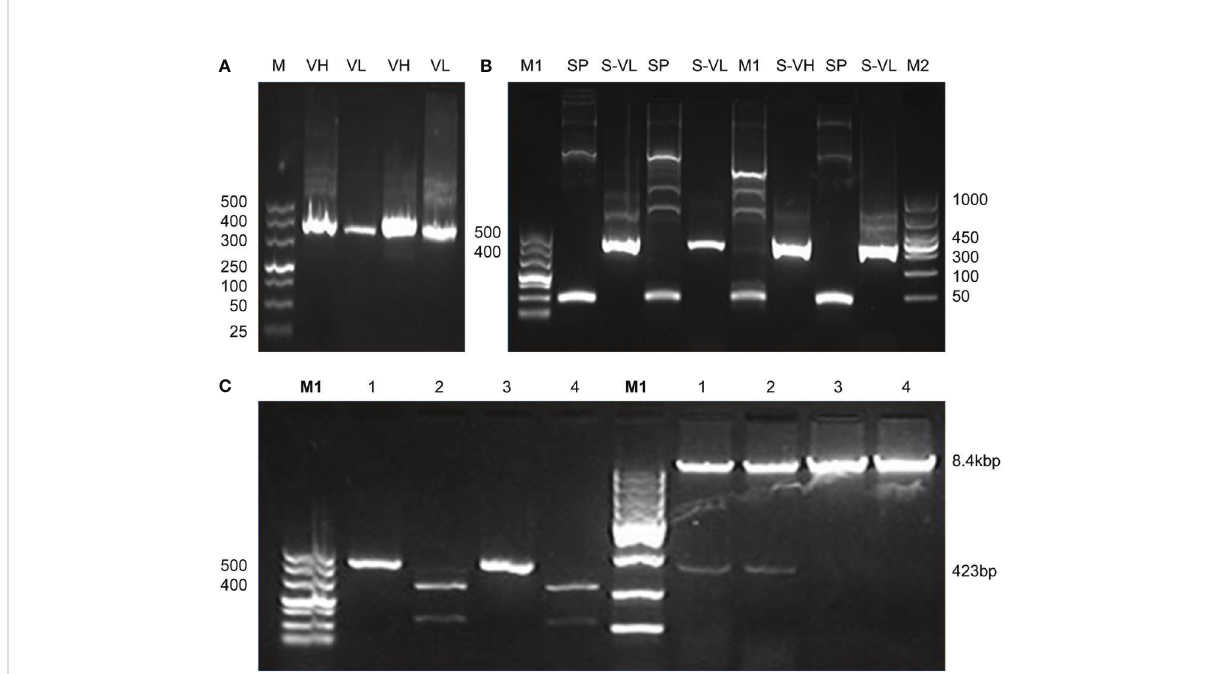
FIGURE 2 (A) Polymerization and ligation of signal peptides with VH/VL fragments. Panel A shows PCR con fi rmation of VH and VL regions. M represents 500 base pairs of molecular markers, VH and VL indicate variable fragments of the heavy chain and light chain. (B) Indicate signal peptide polymerization and its ligation with variable regions. The M1 shows 500 base pairs and the M2 indicates 1000 base pairs of molecular markers. SP indicates 60 base pairs signal peptide, S-VH shows overlapping of signal peptides with the heavy chain of approximately 423 base pairs bands, and S-VL shows overlapping results of a signal peptide with a variable chain of 381 base pairs bands. The tests were repeated twice to con fi gure the integrity. (C) Recombinant con fi rmation of heavy chain variable regions by PCR and enzyme activity. The PCR validation of the heavy chain overlapping construct is shown in the left panel of the fi gure. Positive fi ndings were seen in Lanes 1 and 3. Restricted enzyme activity is shown in the right panel. A positive construct may be seen in Lanes 1 and 2.